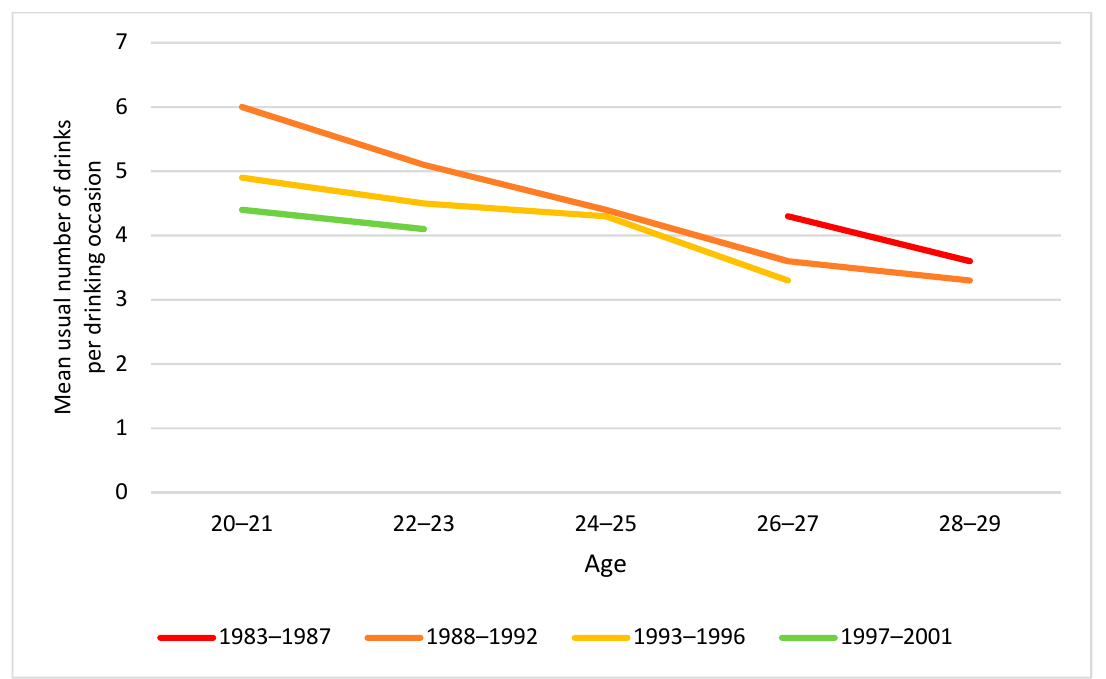
Figure 9. Mean usual number of drinks per drinking occasion by birth cohort and age. Note: At ages 20 – 21, 22 – 23 and 26 – 27, cohorts differed statistically significantly (respective p -values: p < 0.001; p = 0.009; p = 0.009). At ages 24 – 25 and 28 – 29, cohort differences were not statistically significant ( p > 0.05).